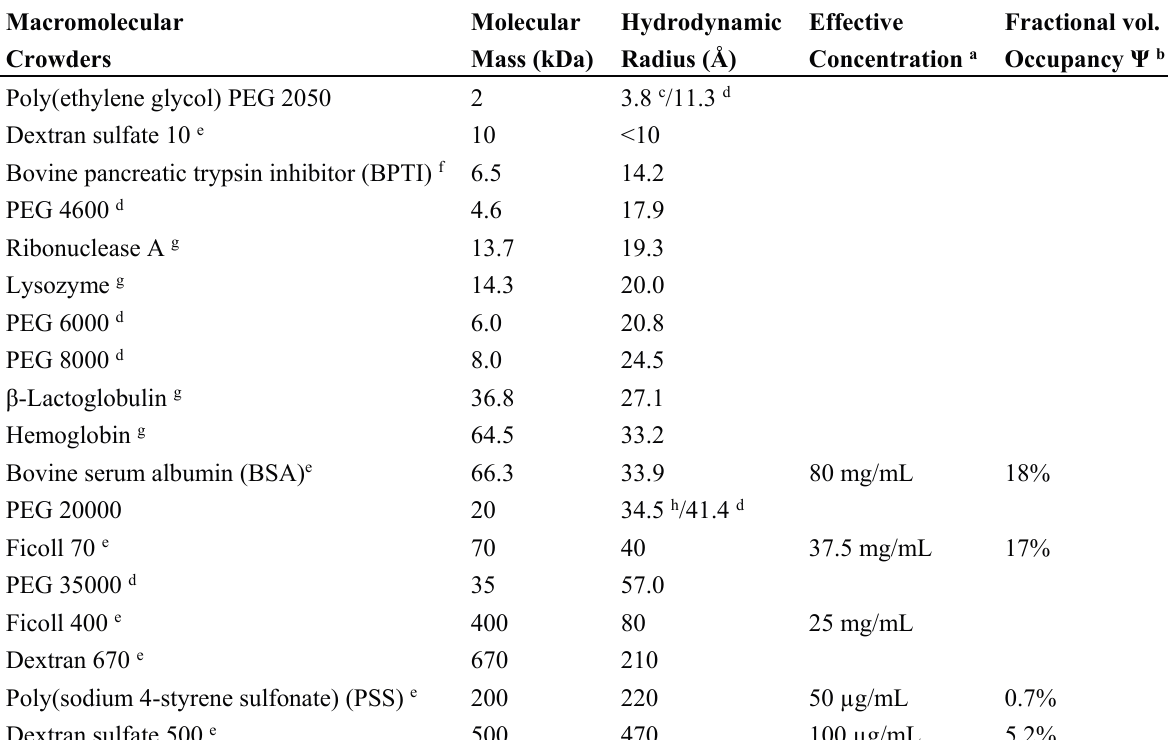
Table 1. Hydrodynamic radii and related parameters of some crowding